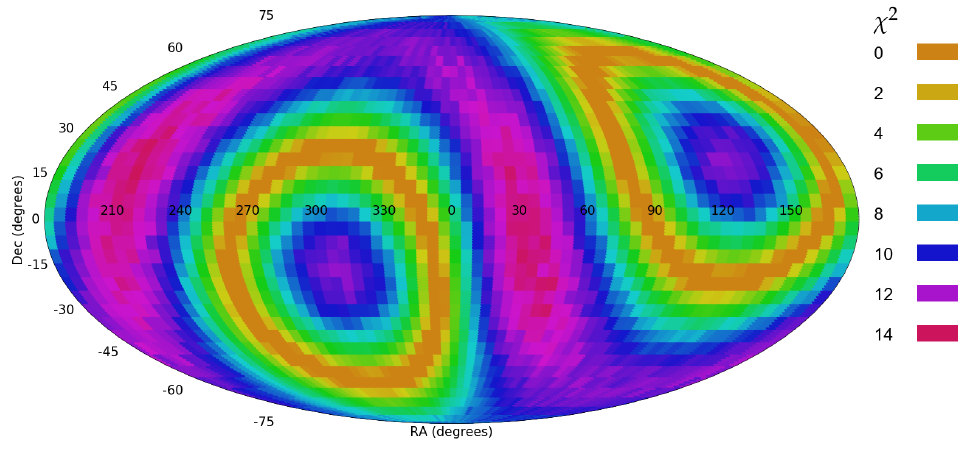
Figure 18. The χ 2 probability of a quadrupole axis such that the galaxies are assigned with random spin directions, except for a certain sky region.